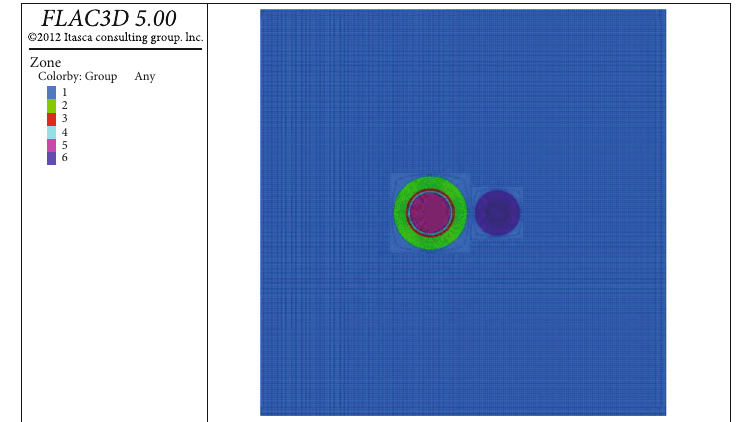
Figure 3: The numerical simulation